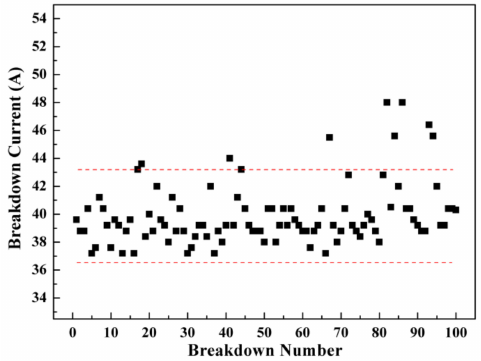
Figure 2. Curve of breakdown current to breakdown